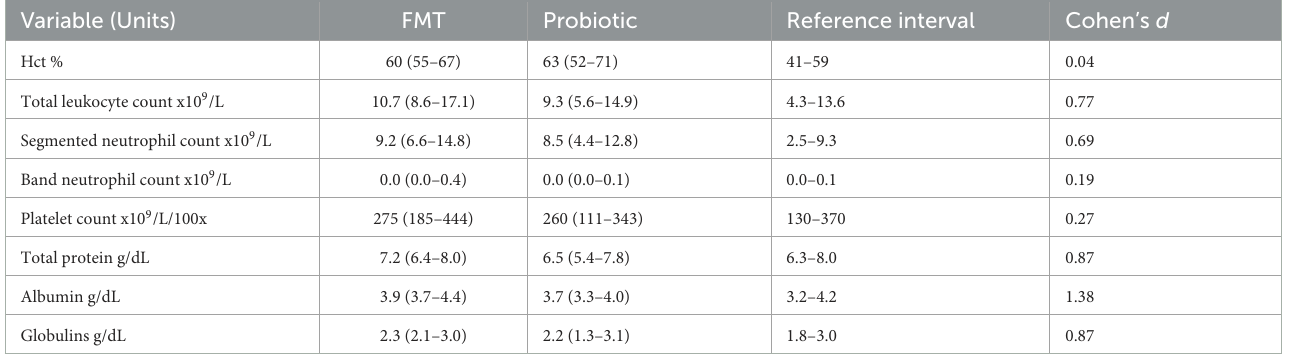
TABLE 1 Selected baseline median (range) clinicopathologic values for 18 dogs with acute hemorrhagic diarrhea syndrome receiving either FMT or probiotic compared using standardized difference.